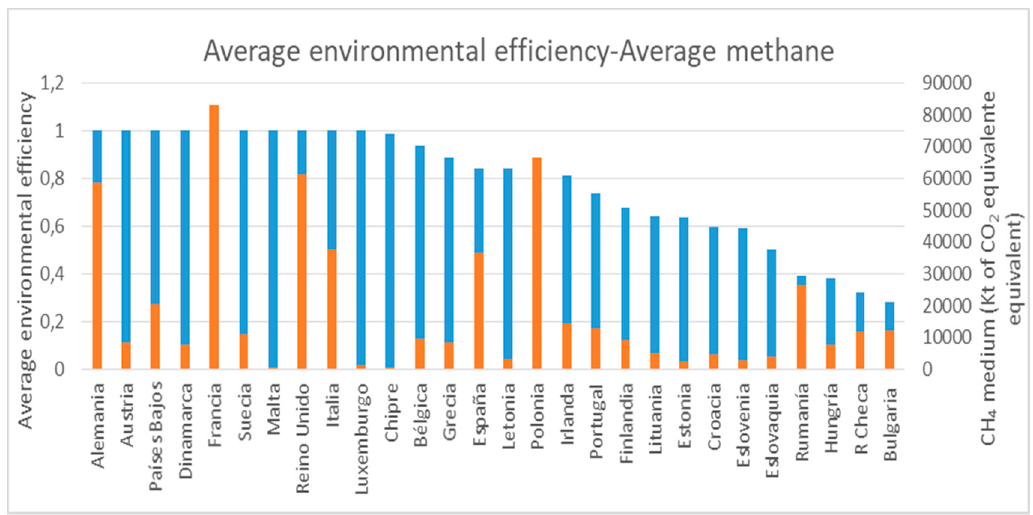
Figure 14. Comparison between the average environmental efficiency obtained with the mean between the DEA Method 1 and the 2 medium CH 4 method. Source: self